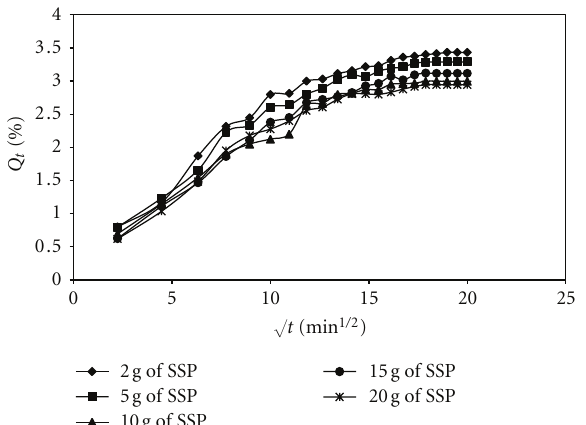
√ t (min 1 / 2 ) for snail shell powder